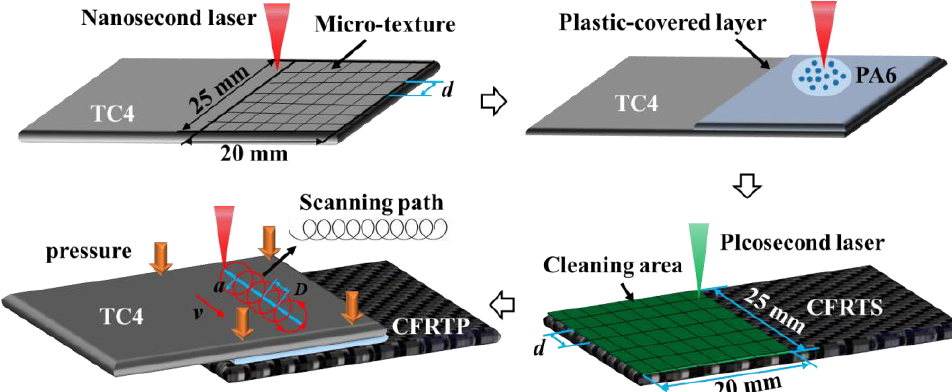
Figure 1. The interface hybrid pretreatment process [26,27].